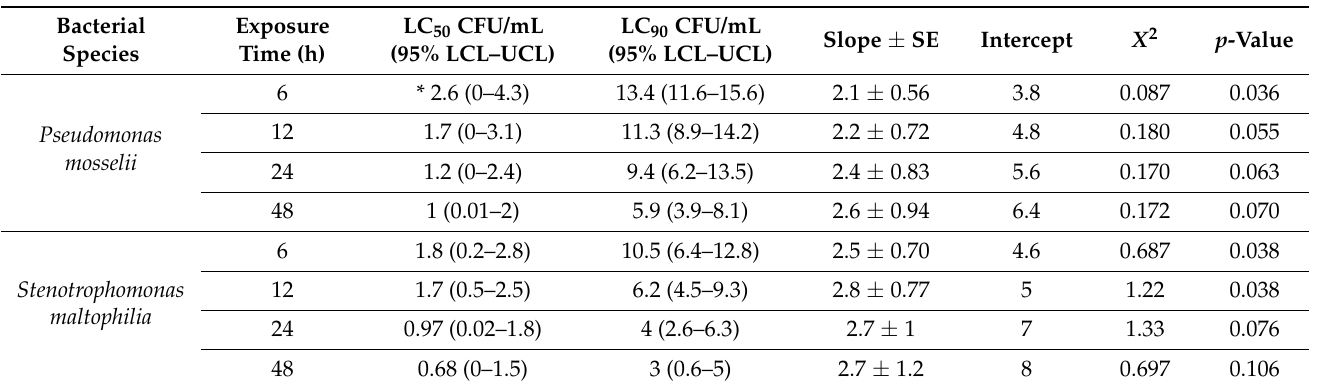
Table 8. Lethal concentrations of Pseudomonas mosselii and Stenotrophomonas maltophilia on the carob moth, Ectomyelois ceratoniae , under laboratory